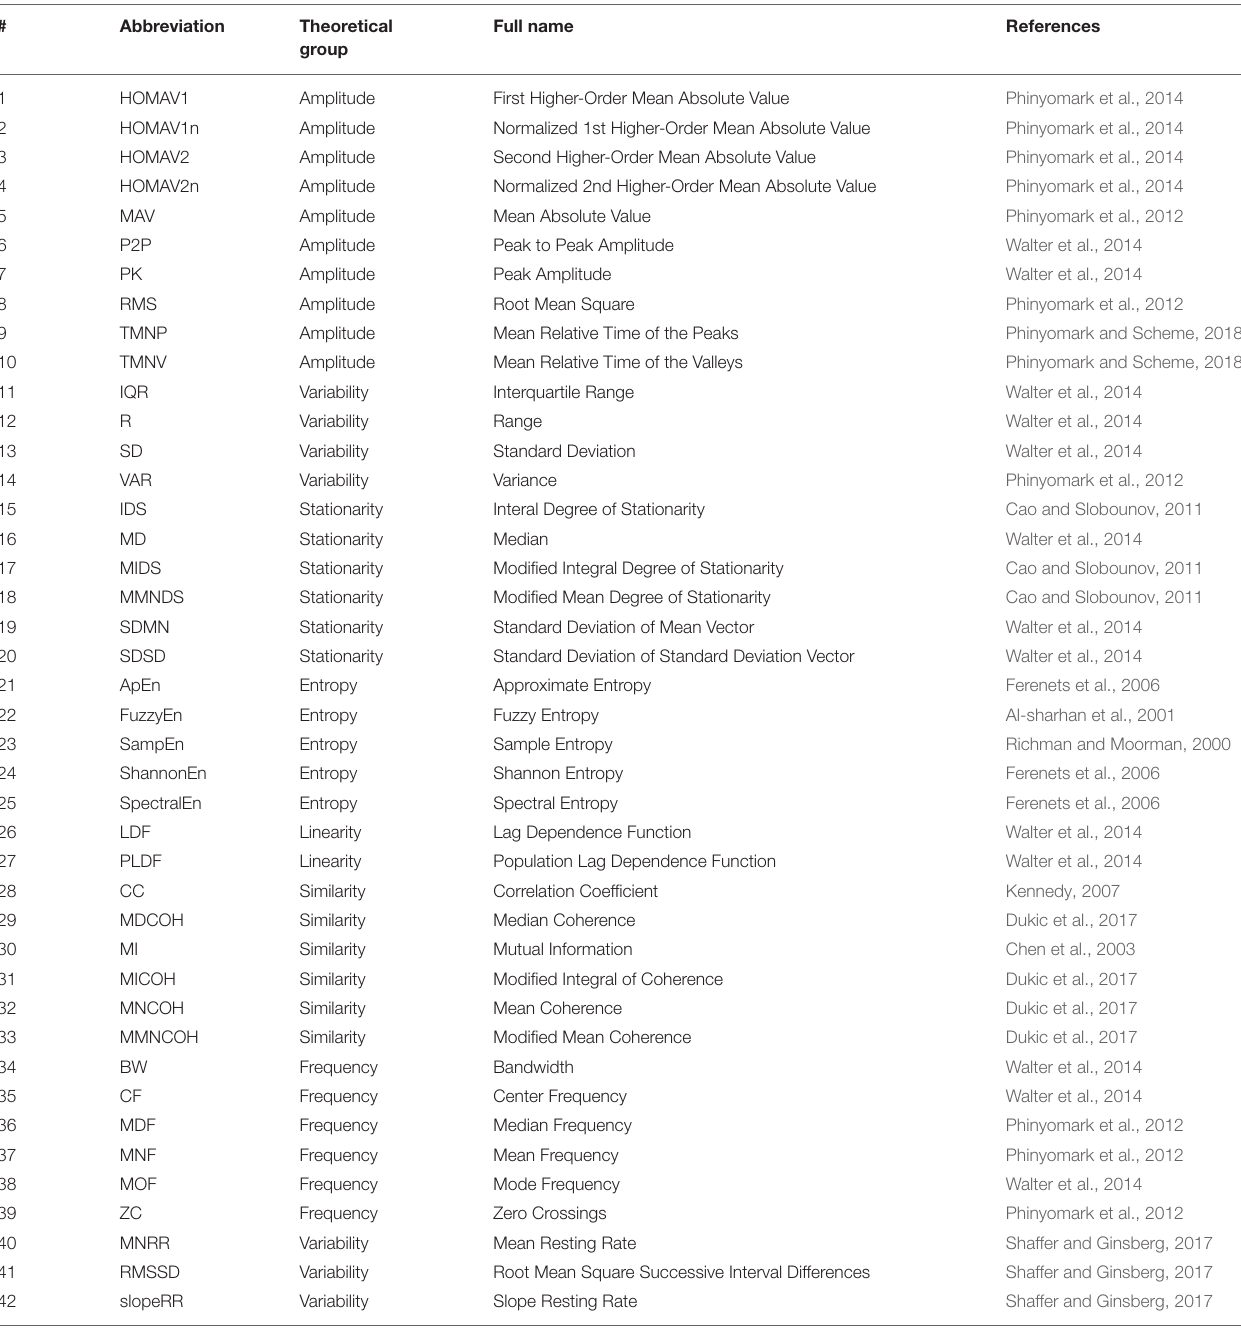
TABLE 1 | List of all features included in the exploration, in alphabetical order and theoretical